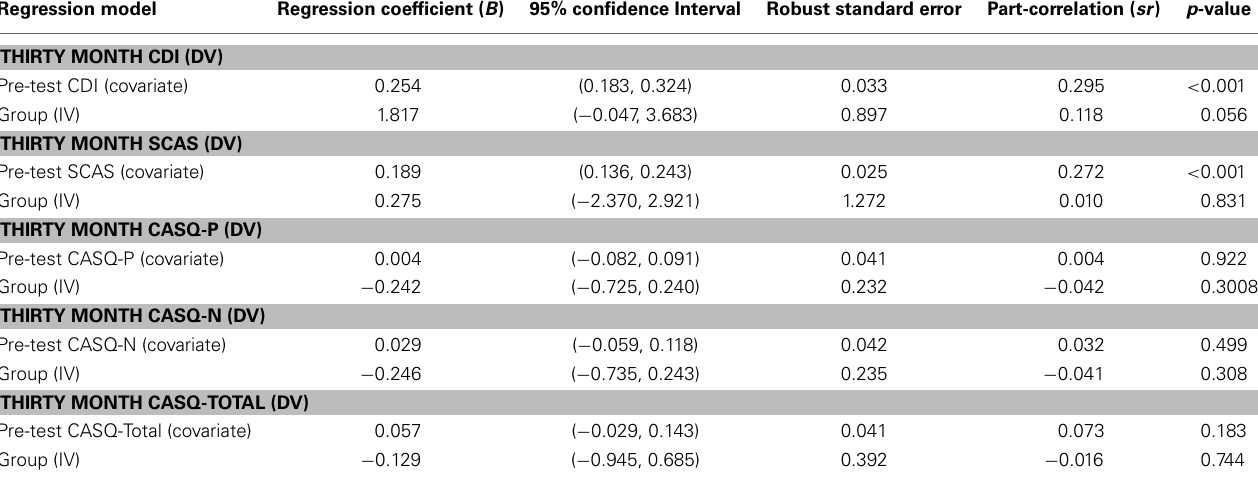
Table 2 | Results for regression analysis testing intervention effects on student-reported outcomes (controlling for clustering in 22